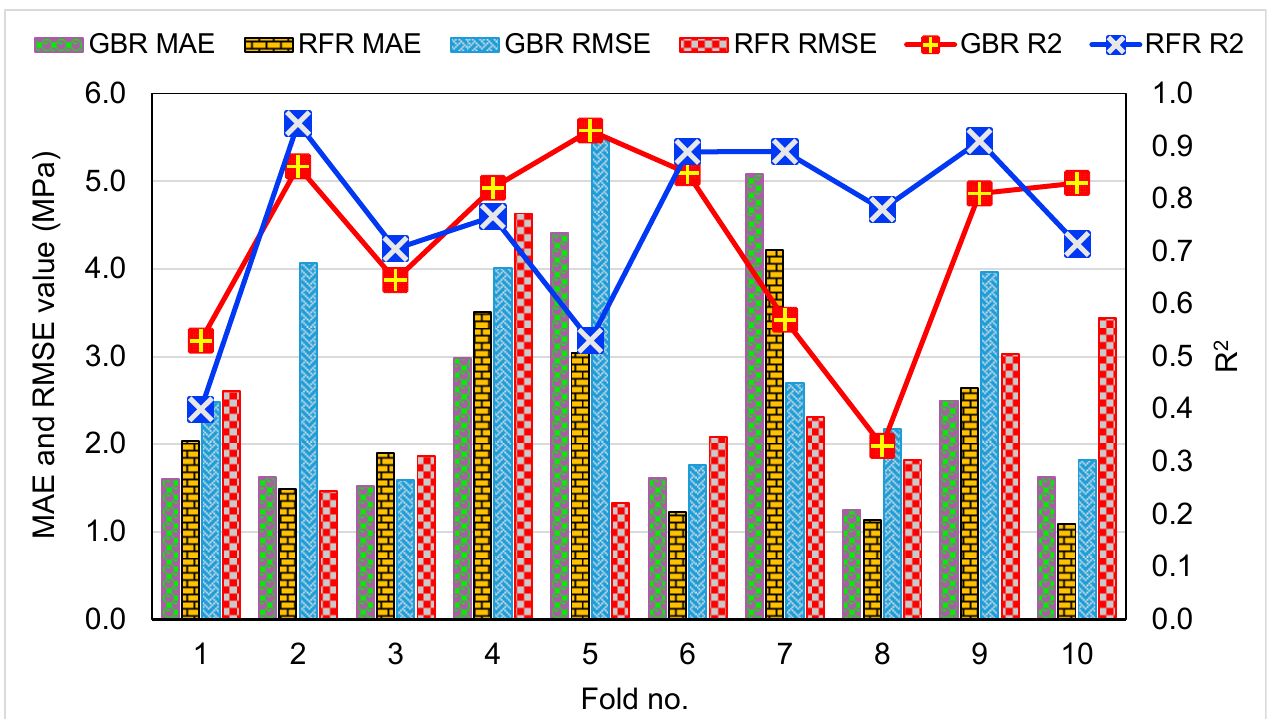
Figure 11. Results of k-fold assessment, indicating MAE, RMSE, and R 2 for GBR and RFR models for the CS estimation.